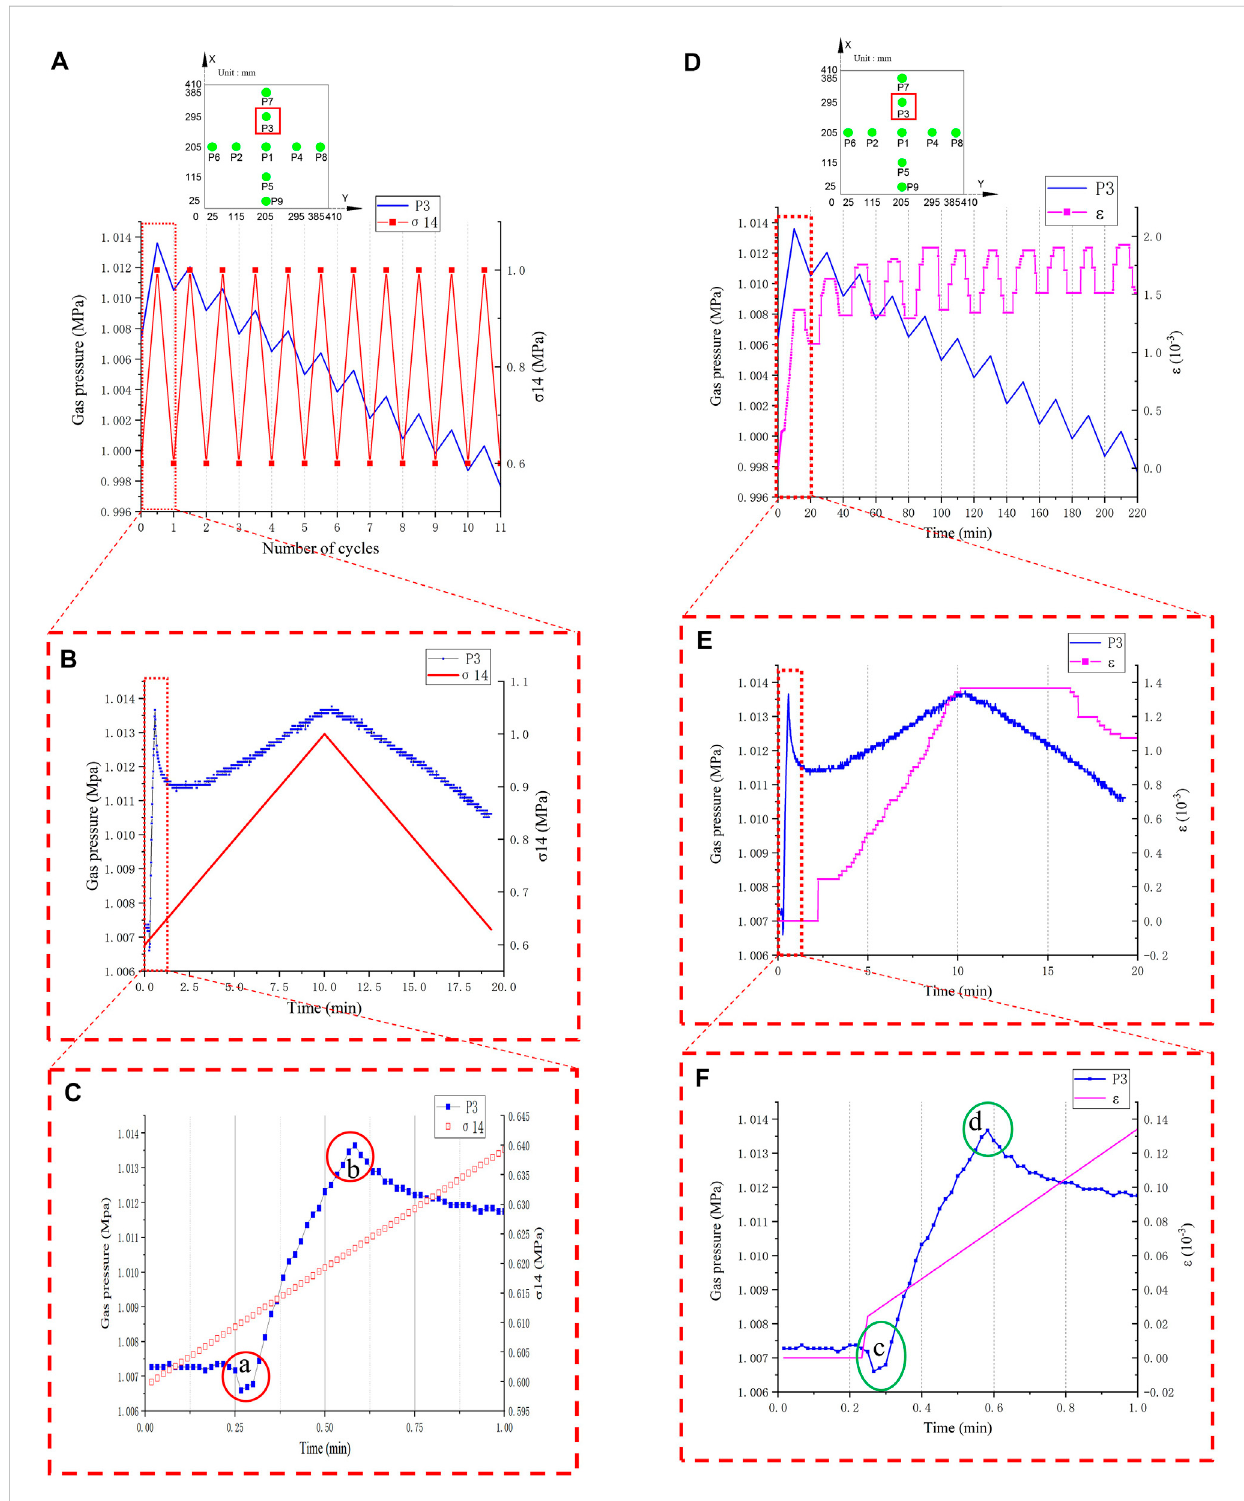
FIGURE 5 The variation of gas pressure with stress and strain. (A) The variation in gas pressure with stress under 11 cyclic loads. (B) The change in gas pressure with stress under the fi rst cyclic load. (C) The change in gas pressure with stress under the previous minute loading. (D) The variation in gas pressure and coal strain under 11 cyclic loads. (E) The change in gas pressure and coal strain under the fi rst cyclic load. (F) The change in gas pressure and coal strain under loading in the last